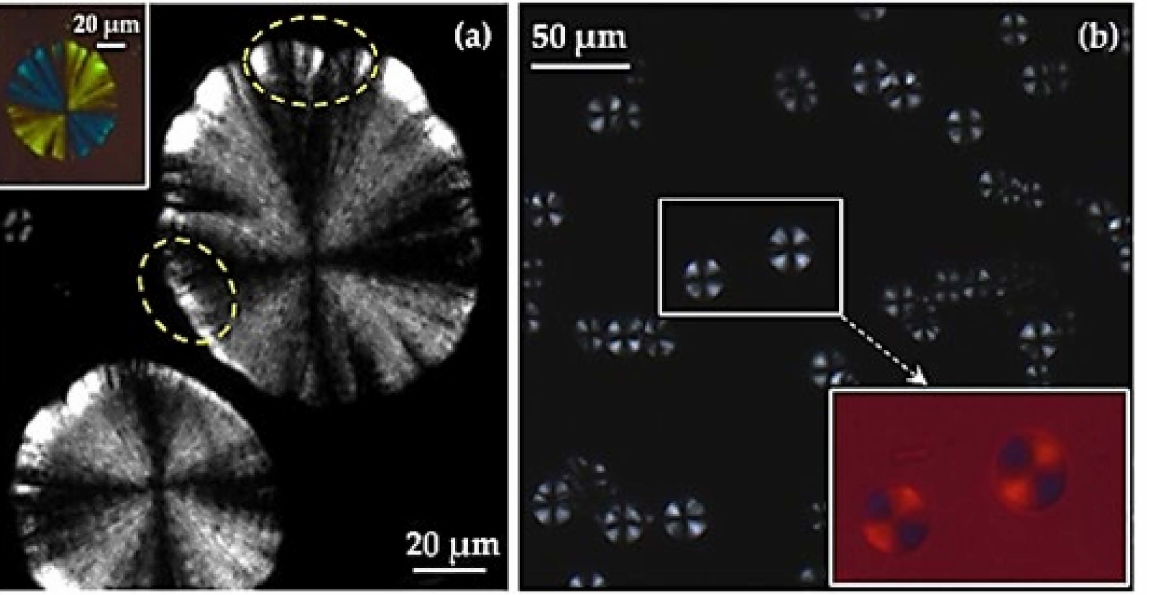
Figure 5. Spherulitic morphologies of PLC attained during slow evaporation of diluted chloroform solutions. Borders and sizes point out the crystallization of fractions with low ( a ) and medium ( b ) molecular